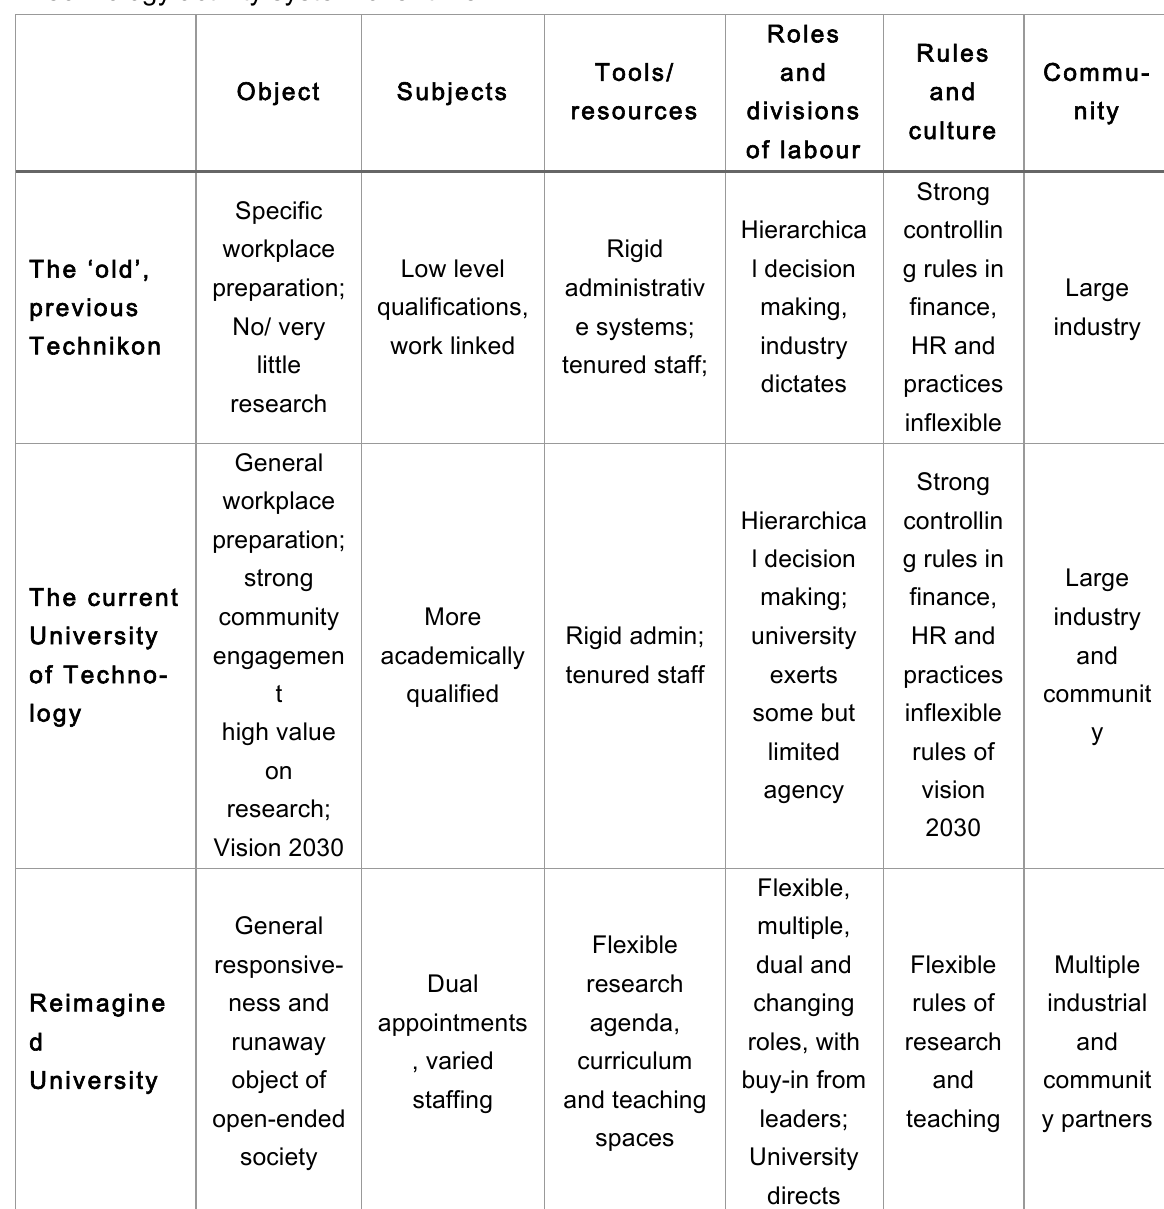
Table 1: Summary of findings: changes and stasis in the elements of the University of Technology activity system over